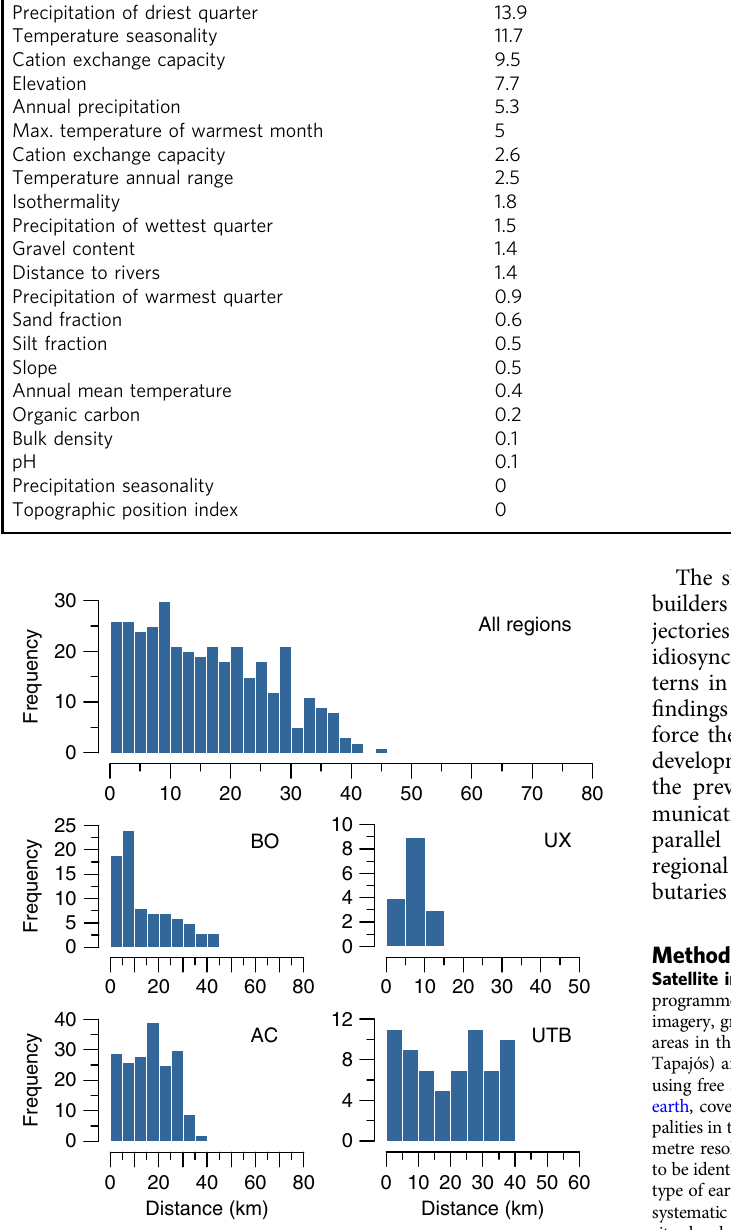
Fig. 7 Frequency of SRA ditched enclosures as a function of distance from rivers. Perennial rivers are de fi ned as fl ow accumulation >15,000 (see Methods). Regions: BO ring ditches of Bolivia and neighbouring Rondônia, UX Upper Xingu, AC geoglyphs of Acre and neighbouring Amazonas, UTB Upper Tapajós Basin. The limits of the x axis correspond to the maximum potential distance in the respective